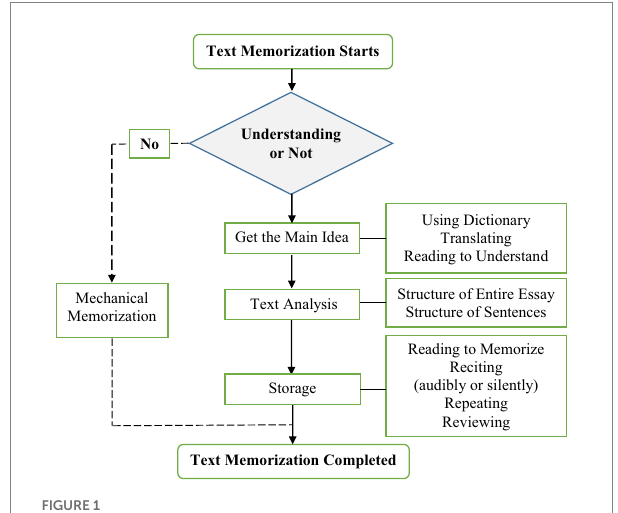
FIGURE 1 Diagram of text memorization process and strategies used by Chinese EFL learners (source: